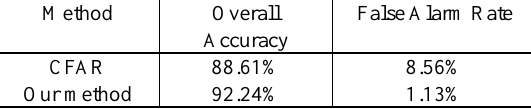
Table 2. Performance Evaluation of change detection Over LiangZi